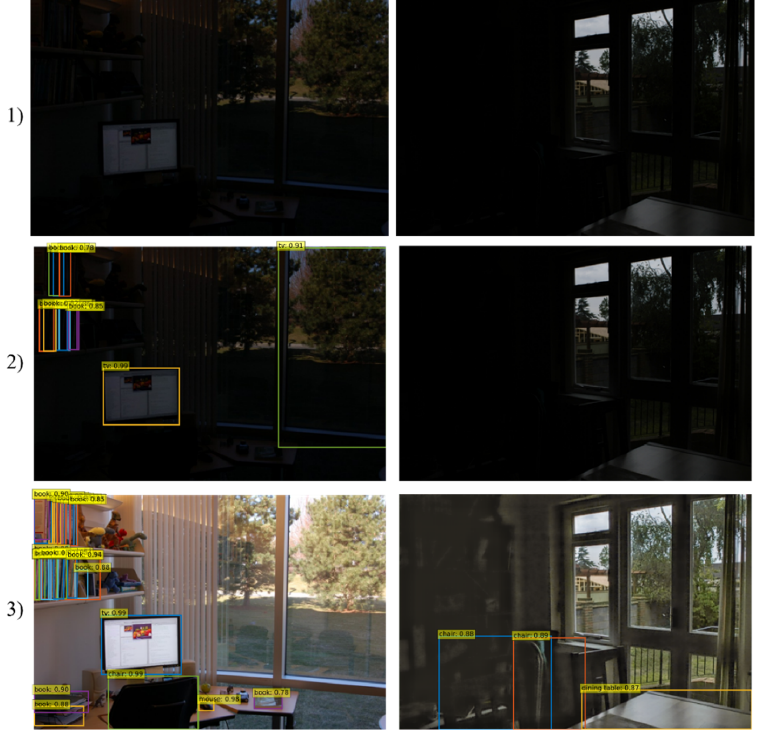
Figure 15. The results of object detection model on the challenging LOL datasets. ( 1 ) low-light input images; ( 2 ) object detection before image enhancement; ( 3 ) object detection after image enhancement.